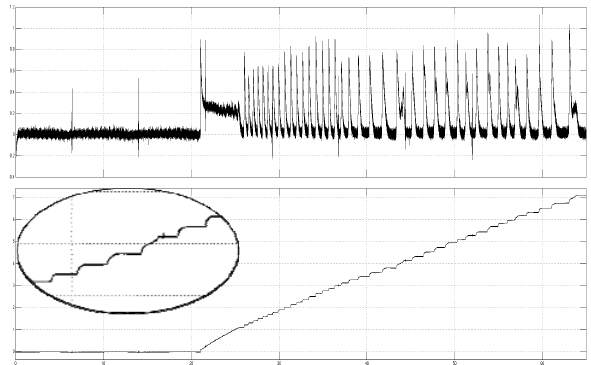
Fig. 1. Real pneumatic piston drive with stick – slip effect. Top picture – velocity, bottom – position, approximate velocity 9.34 mm/s